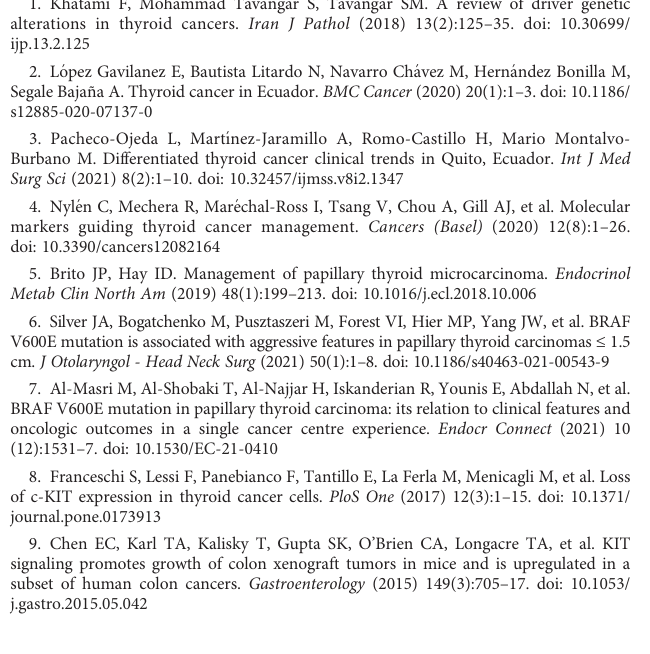
SUPPLEMENTARY FIGURE 1 Three-dimensional structures of wild and mutant proteins, obtained with the Swissmodel tool. (A) Wild Type BRAF Protein (P15056, extracted from UniProt). (B) Mutant protein (p.Val600Glu). (C) Close-up of the BRAF genetic mutation identi fi ed in the patient by NGS. The wild-type residue is in red, whereas the mutant residue is in green. SUPPLEMENTARY FIGURE 2 Three-dimensional structures of wild and mutant proteins, obtained with the Swissmodel tool. (A) Wild Type KIT Protein (P10721-1, extracted from UniProt). (B) Mutant protein (p.Leu678Phe). (C) Close-up of the mutation. The KIT protein is colored grey, the side chains of both, the wild-type and the KIT Leu678Phe variant residue are shown and colored green and red